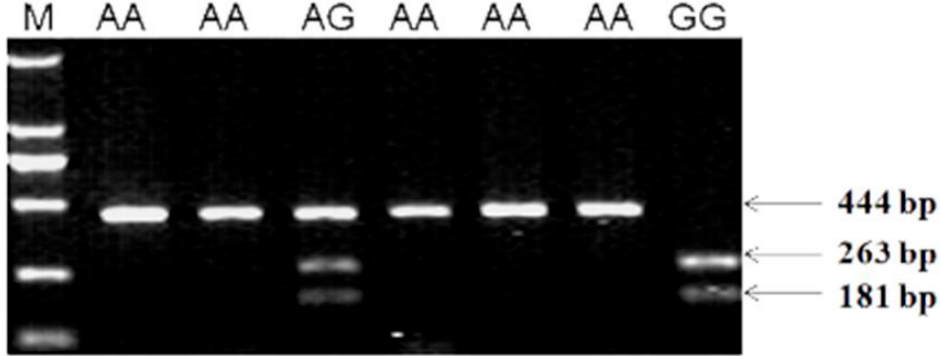
Figure 4. Agarose gel electrophoresis result of PCR-RFLP. The electrophoresis patterns obtained after digestion with Sdu I endonuclease at the c.890A>G locus. Agarose gel electrophoresis (1.5%) image showing the DNA restriction fragment patterns indicative of polymorphisms in BCO2 gene after amplification with the primer pair YSD-F/R. The genotypes are shown at the top of the lanes, M, Marker DL2000 DNA Ladder